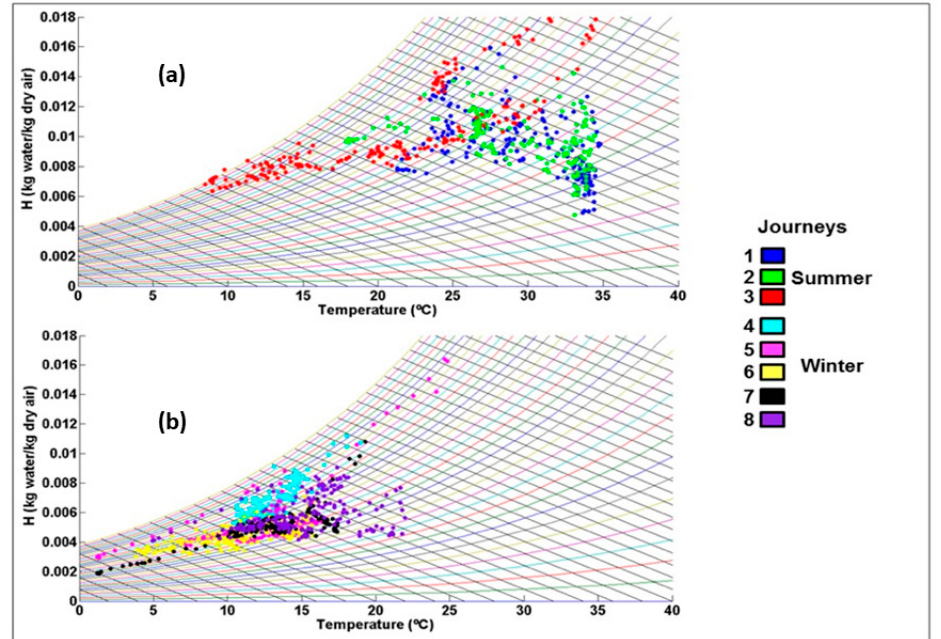
Figure 2. Psychrometric graph of the average temperatures (in ◦ C) inside the livestock vehicle during transport from Spain to Portugal in ( a ) summer and ( b ) winter throughout the day with humidity (H kg water/k of dry air) plotted against temperature for each journey.